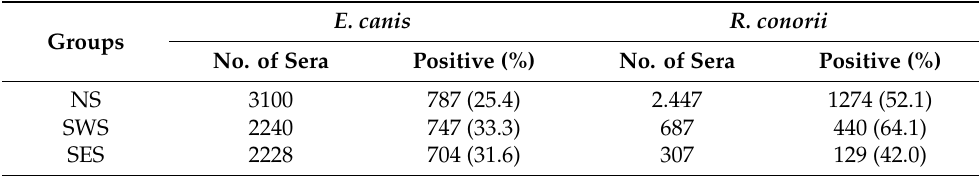
Table 3. Serological results in relationship to spatial variations: Northern Sicily (NS), South Western Sicily (SWS), and South Eastern Sicily (SES).